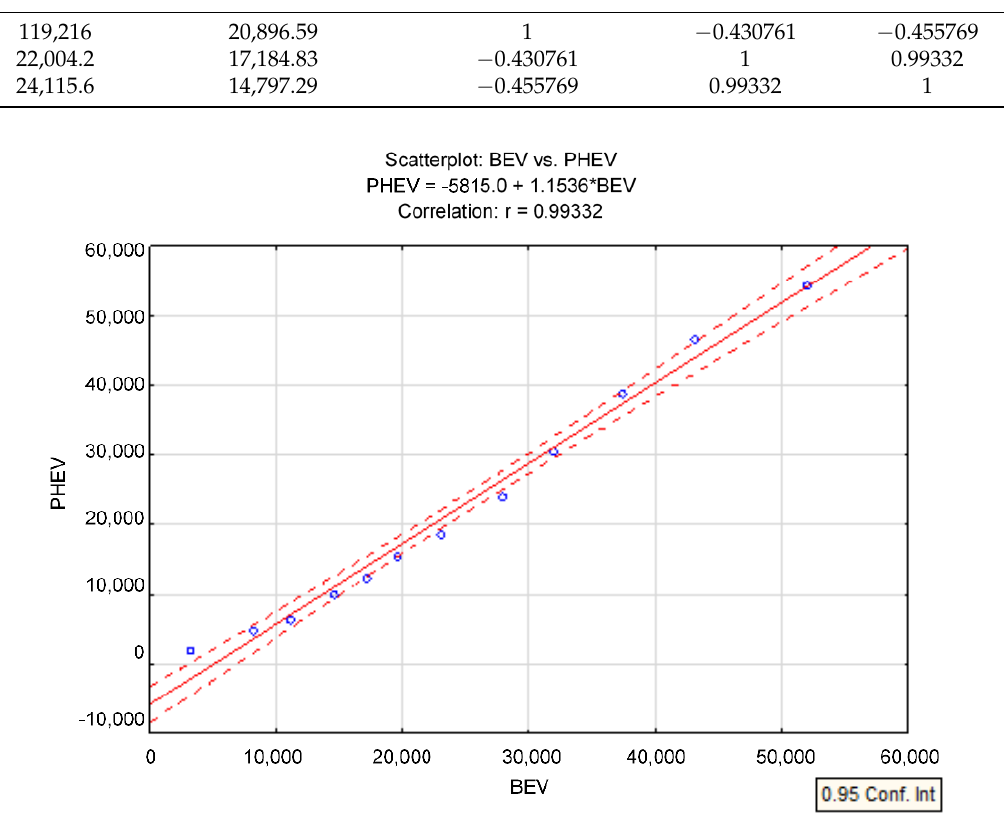
Figure Figure 10. Number of BEVs and PHEVs on the market in Poland in 2019 – 2021 by linear correlation- scatterplot.